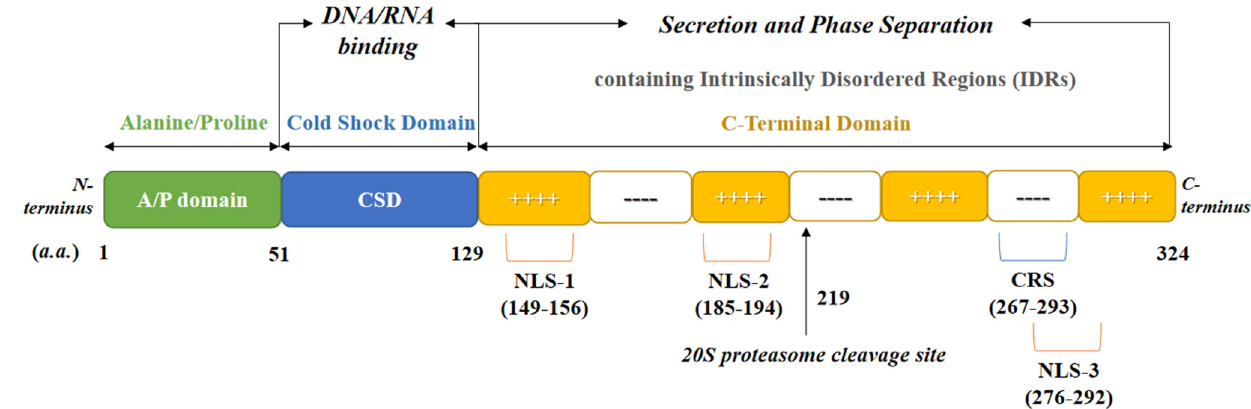
Figure 1. YB-1 protein structure and function domains. The YB-1 protein consists of 324 amino acid residues. YB-1 has an alanine and proline-rich A/P structural domain at the N-terminus, a cold-shock structural domain in the middle segment, and a C-terminal structural domain. The nuclear localization signal (NLS), S20 proteasome cleavage site, and cytoplasmic retention site (CRS) located at the C-terminus are also labeled.